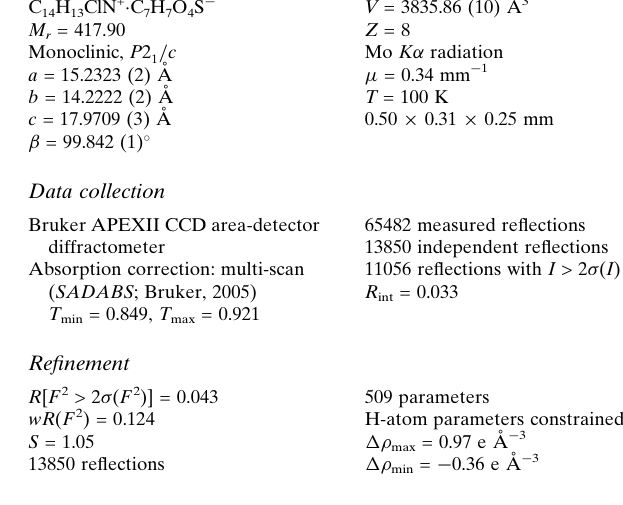
Data collection Bruker APEXII CCD area-detector diffractometer Absorption correction: multi-scan ( SADABS ; Bruker, 2005)